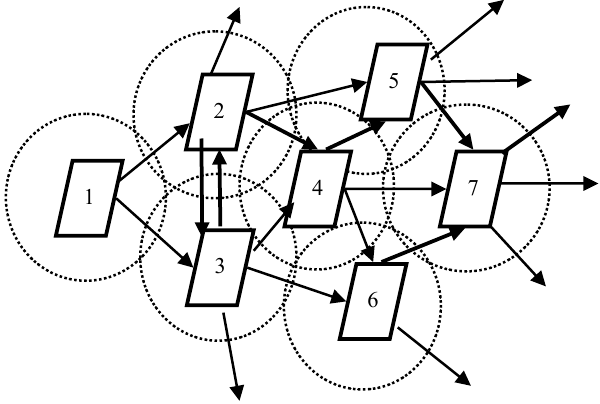
Figure 4. Broadcast Storm